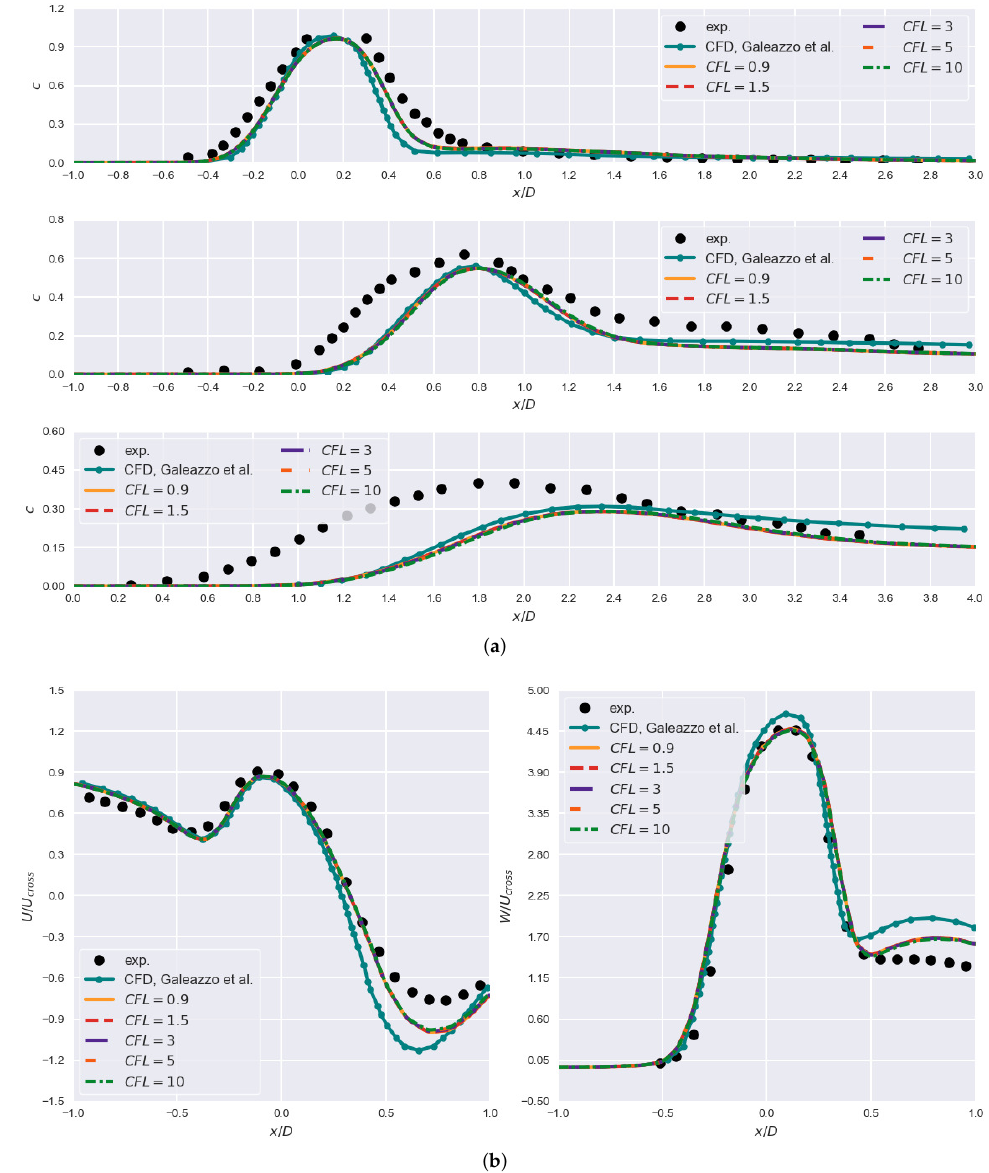
Figure A2. Results for different CFL values on fine grid with k − ω TNT model: ( a ) concentration of passive scalar c at z / D = 1.5, z / D = 3, z / D = 4.5 (top to bottom) where y / D = 0; ( b ) profiles of mean velocity components for y / D = 0 and z / D =